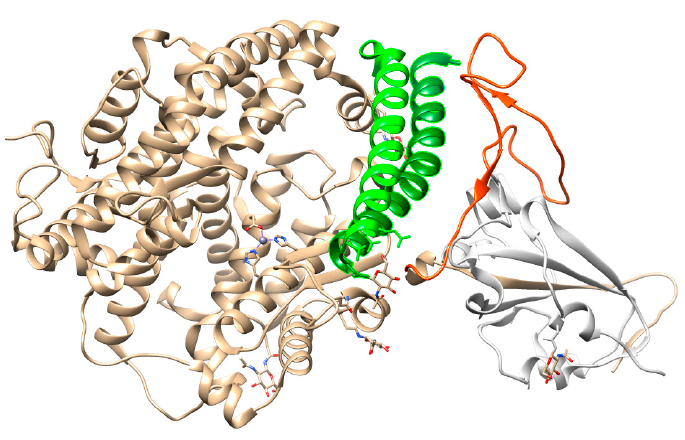
Figure 2. Interactions between SARS-CoV-2 RBD (in orange) and ACE2 (the main interacting α 1 helix in dark green, the α 2 helix also contributing to the interaction in green), visualized by USCF Chimera. PDB ID: 6M0J.